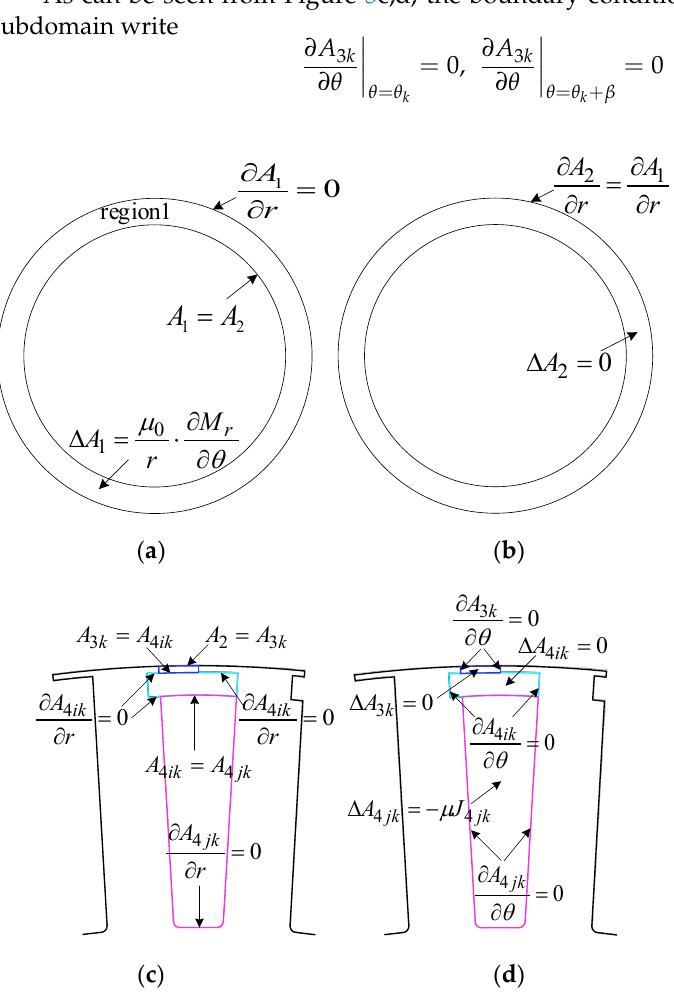
Figure 5. Boundary conditions of each subdomain. ( a ) PMs; ( b ) air gap; ( c ) radial asymmetric slot opening and slot body; ( d ) circumferential asymmetric slot opening and slot body.